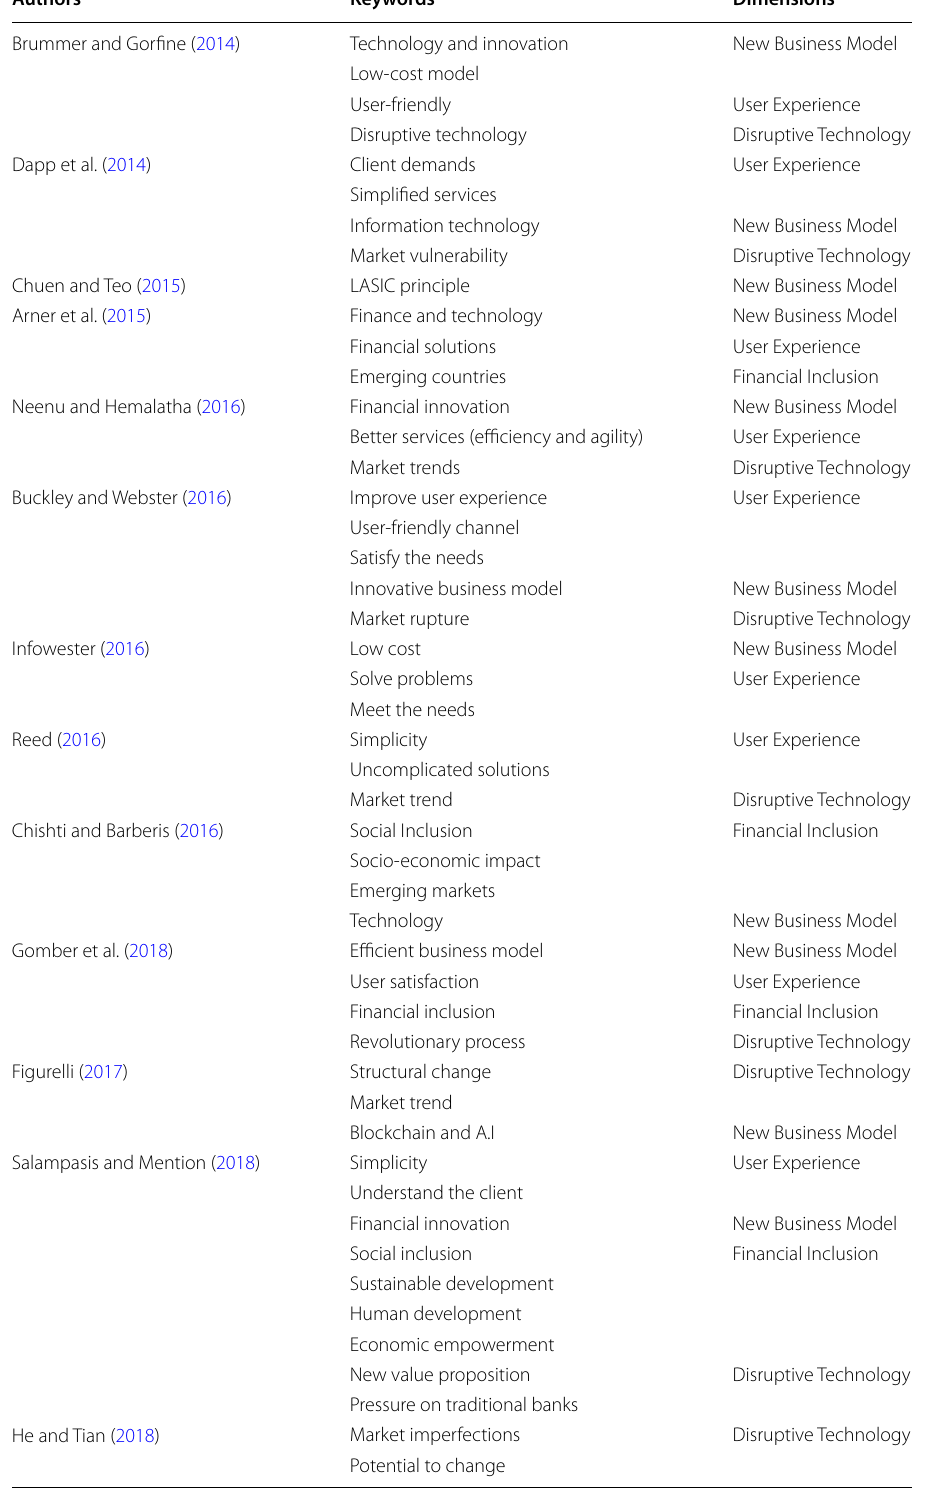
Table 1 Fintech dimensions from the scientific literature